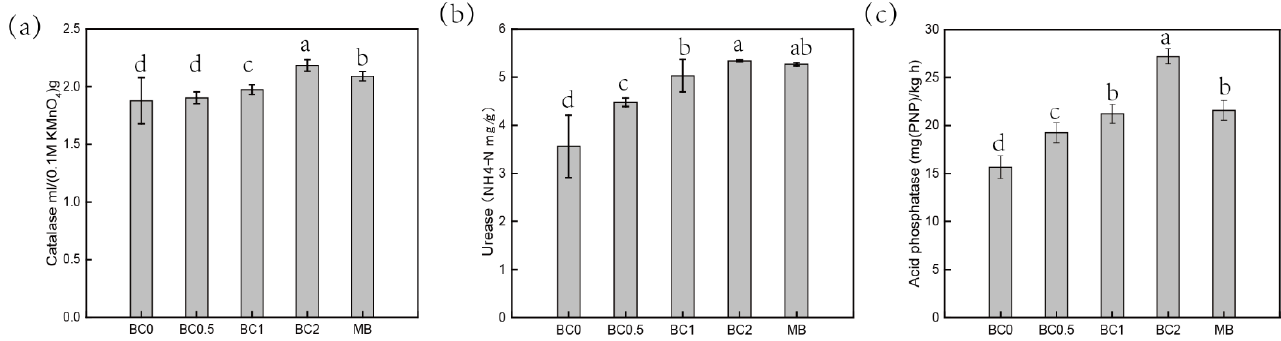
Figure 2. Influence of the biochar on enzyme activities. CAT ( a ), Catalase activities; UR ( b ), Urease activities; ACP ( c ), Acid phosphatase activities. BC0, BC0.5, BC1, and BC2 mean as soil applied with T-BC of four rate (0, 0.5, 1, and 2% (w/w)); MB means as soil applied with biochar (2% (w/w)) from mango leaves.